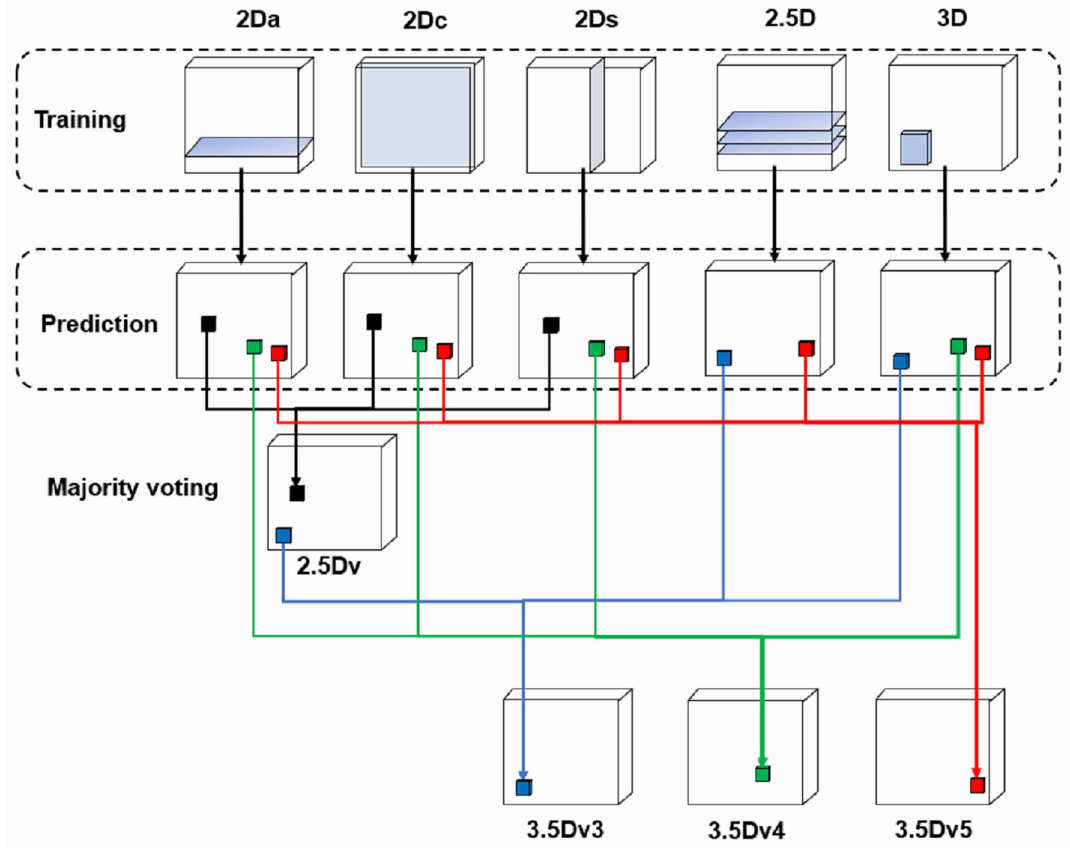
Figure 2. Schematics of the 2.5D U-Net and our proposed 3.5D U-Nets using majority voting. The 2.5D U-Net combines the predictions of deep learning models trained by 2Da U-Net, 2Dc U-Net and 2Ds U-Net. The 3.5Dv3 U-Net combines the predictions of deep learning models trained by 2.5Dv U-Net, 2.5D U-Net and 3D U-Net. The 3.5Dv4 U-Net combines the predictions of deep learning models trained by 2Da U-Net, 2Dc U-Net, 2Ds U-Net and 3D U-Net. The 3.5Dv5 U-Net combines the predictions of deep learning models trained by 2Da U-Net, 2Dc U-Net, 2Ds U-Net, 2.5D U-Net and 3D